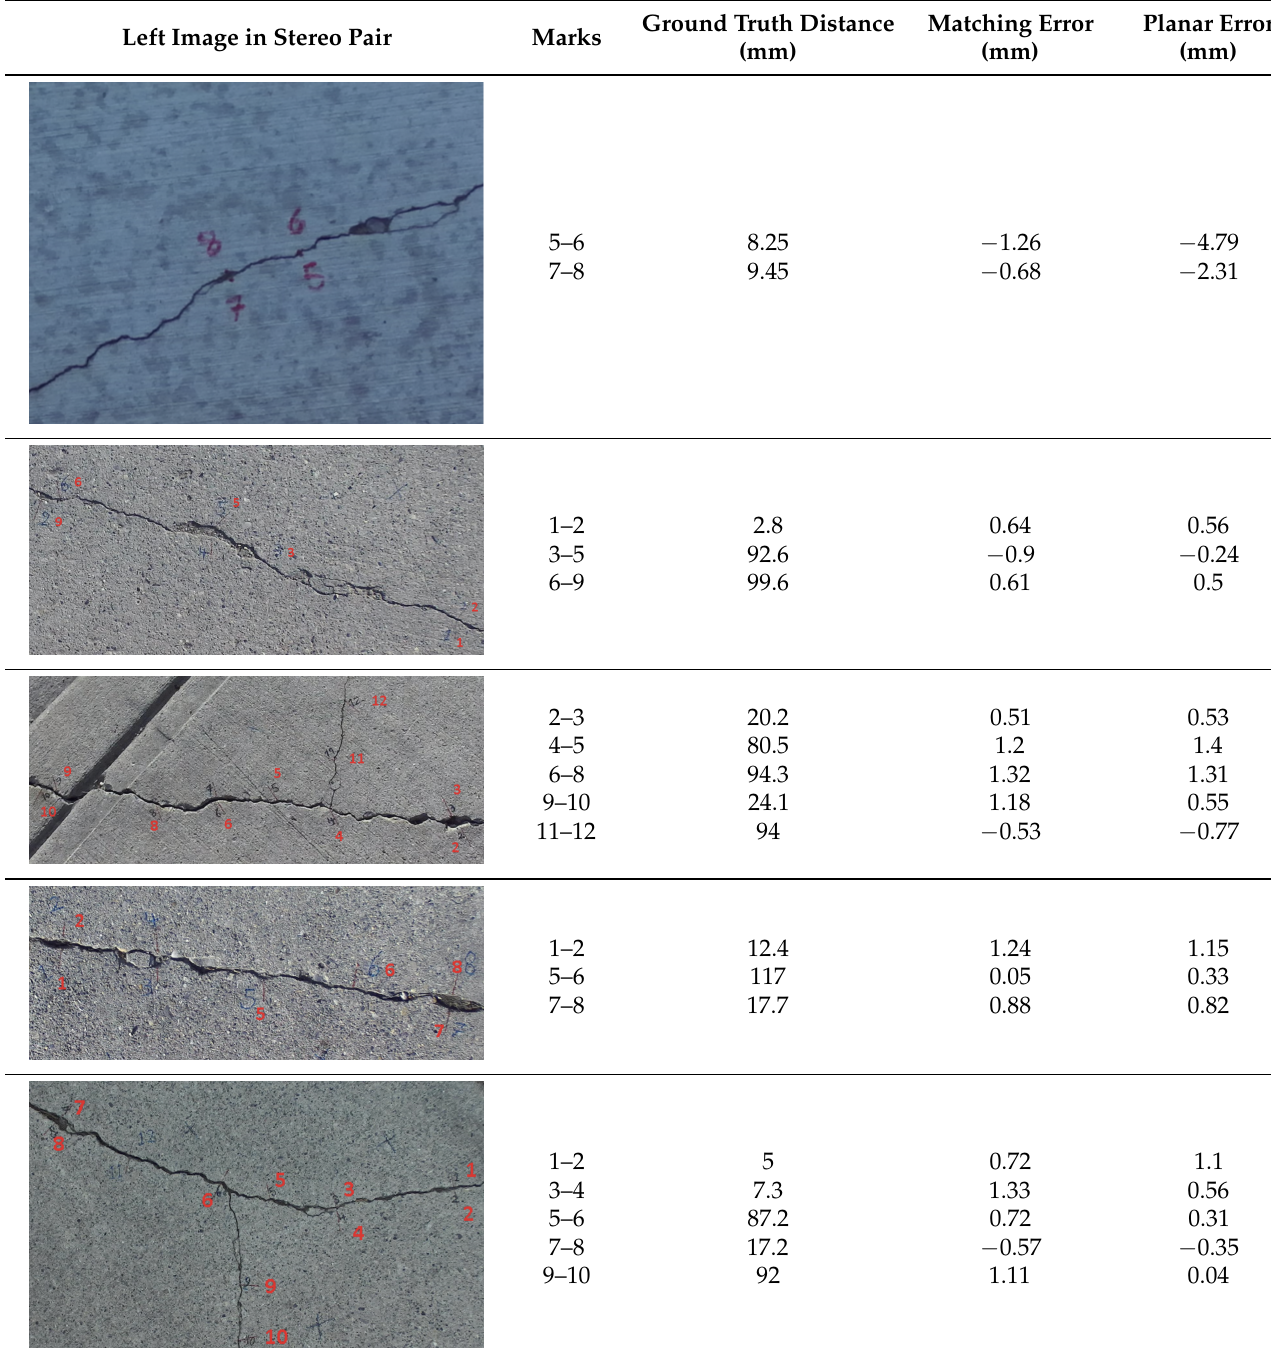
Table A1. Ground truth distances of checkmark pairs in ten stereo image pairs used for the evaluation of 3D reconstruction. Left Image in Stereo Pair Marks